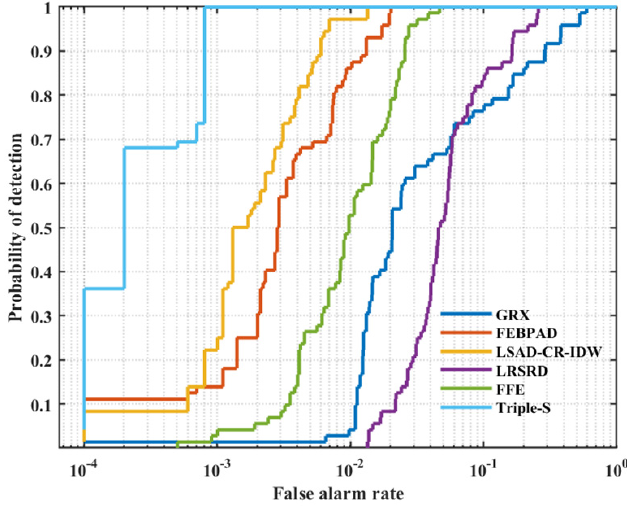
Figure 7. Receiver operating characteristic (ROC) curves for AVIRIS San Diego airport dataset.